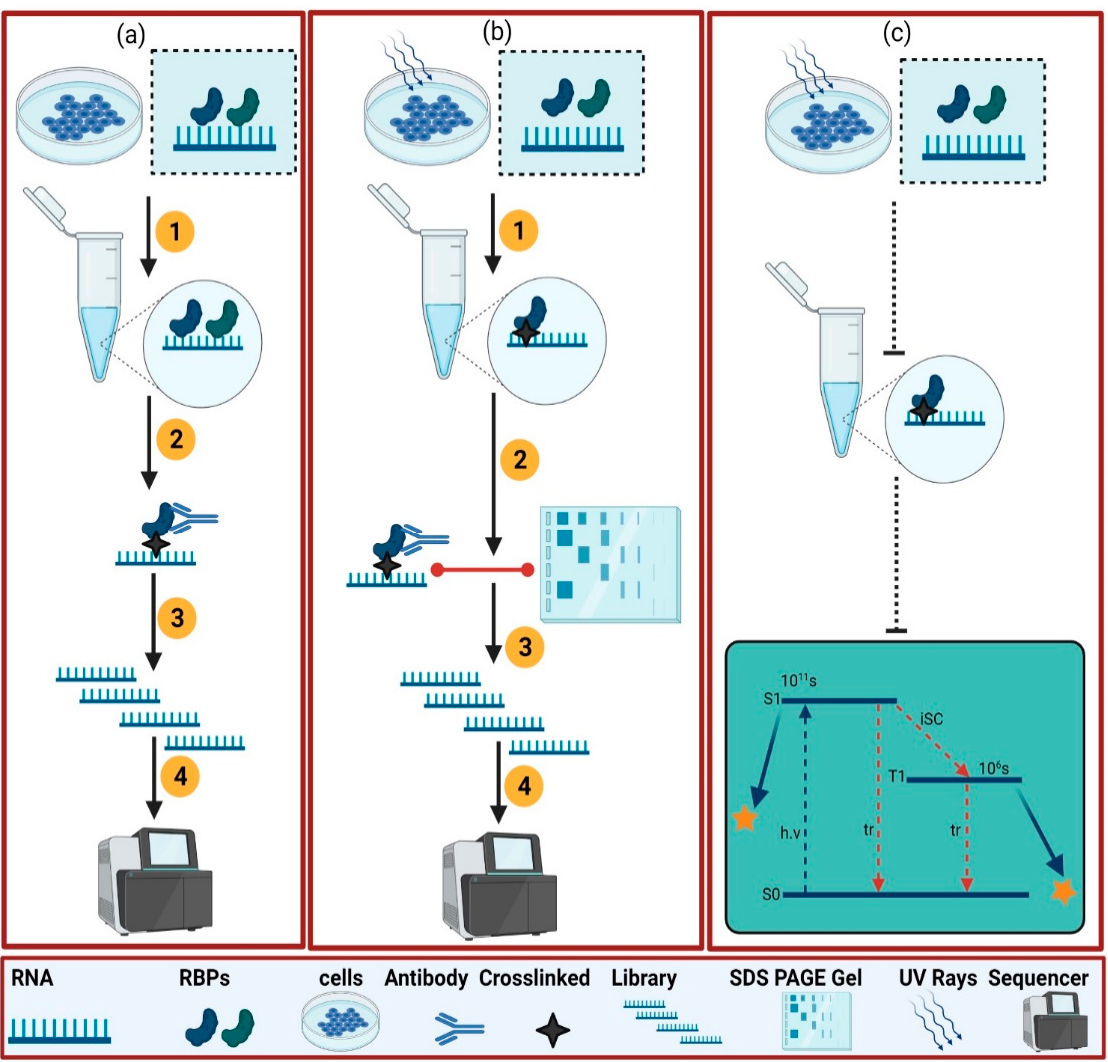
Figure 2. This illustrates the protein-centric method applied in eukaryotes. For the protein-centric method, two kinds of variants are generally used: native purification ( a ) and the denaturing method ( b ) [14]. ( a ) is showing the native purification method which is called RNA immunoprecipitation (RIP). It consists of several steps to experiment with call lysate containing targeted and other RBPs (1), capturing of targeted RBPs with a specific antibody (2), RNA library preparation (3), and sequencing (4). ( b ) works based on UV cross-linking and immunoprecipitation which is called the crosslinking immunoprecipitation (CLIP) method. In the ( a ) method, a specific protein of interest is immunoprecipitated from a cell by a specific protein antibody in the presence of native conditions; UV cross-linking of cells as shown by the star for binding the RBPs and RNA (1), capturing of specific RBPs using an antibody and SDS-page gel analysis confirmation (2), preparation of the associated RNA library (3), and sequencing (4). ( c ) shows a simplified Jablonski diagram [18] and explains the excitation of RNA. During the UV cross-linking mechanism, RNA goes from the ground state (S0) to the excited state (S1). During the procedure, the inter-state conversion (isc) to a triplet (T1) state happens. S1 and T1 are the excited states which fall back to the ground state in 10 (ps) and 1 (µs), respectively. They fall back to the ground state either in the form of thermal relaxation (tr) or the crosslinking formation of RNA with the adjacent amino acid (yellow star).